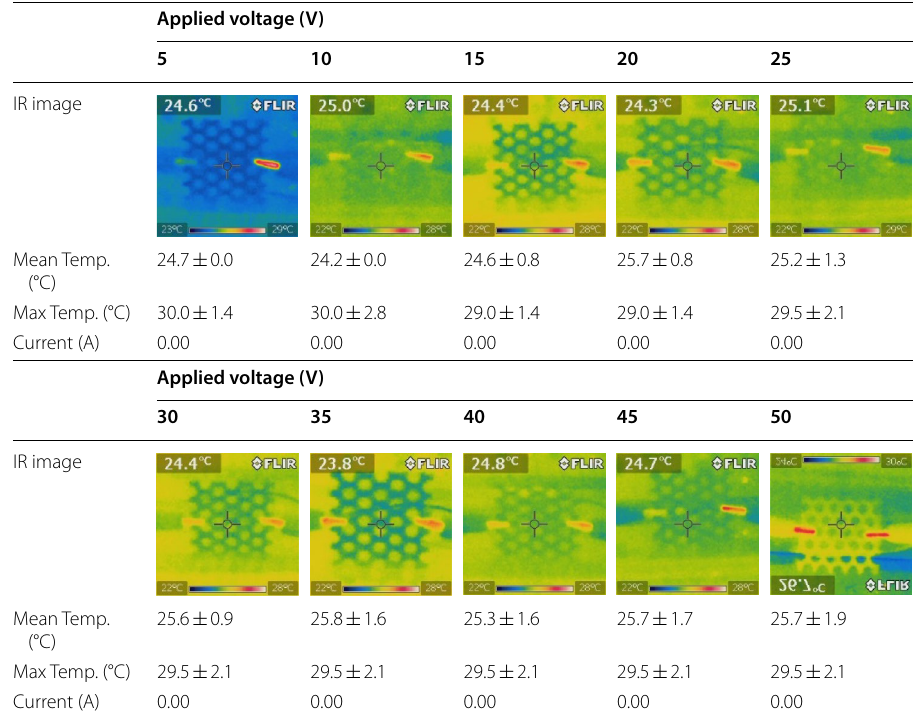
Table 7 IR images of MD PLA 3D printed honeycomb samples